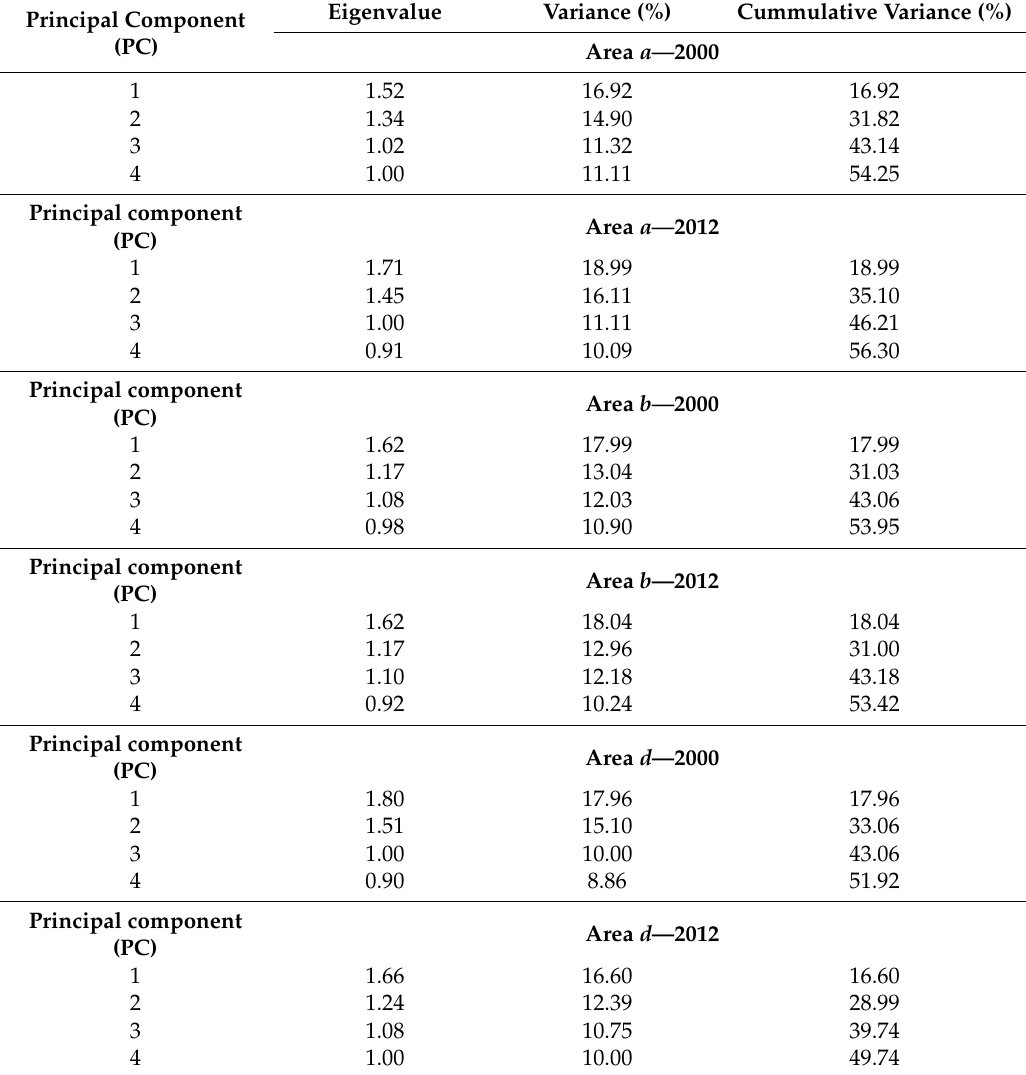
Table 7. Principal components (PCs) for the areas a , b , and d of the Brazilian Cerrado. Principal